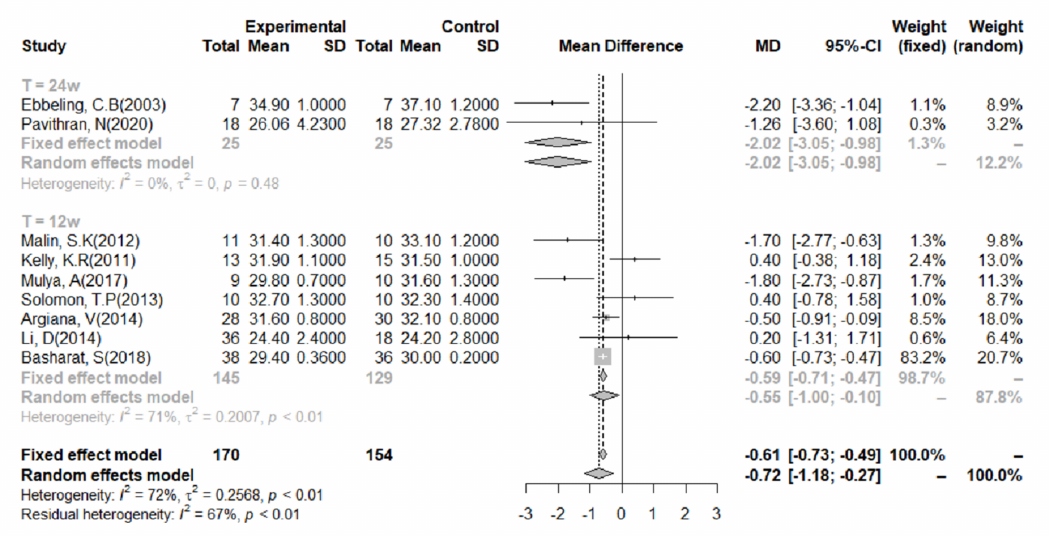
Figure 4. Meta-analysis of the effect of a low-glycemic index diet on body mass index, using data categorized according to the duration of the intervention. A random-effects model and mean difference analysis were